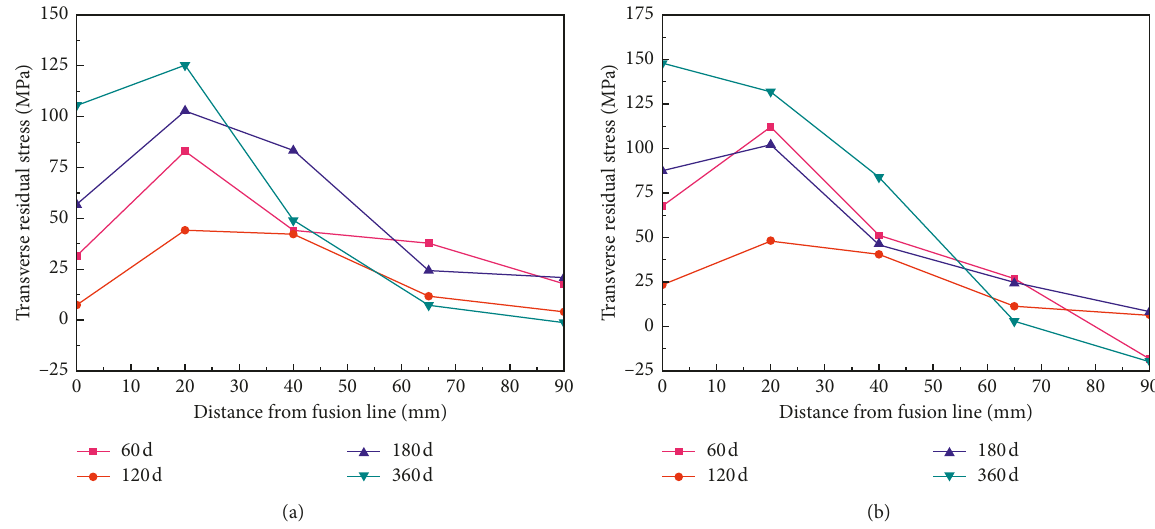
Figure 7: Evolution law of transverse residual stress distribution. (a) Welded structure processed by VSR. (b) Welded structure unprocessed by VSR.